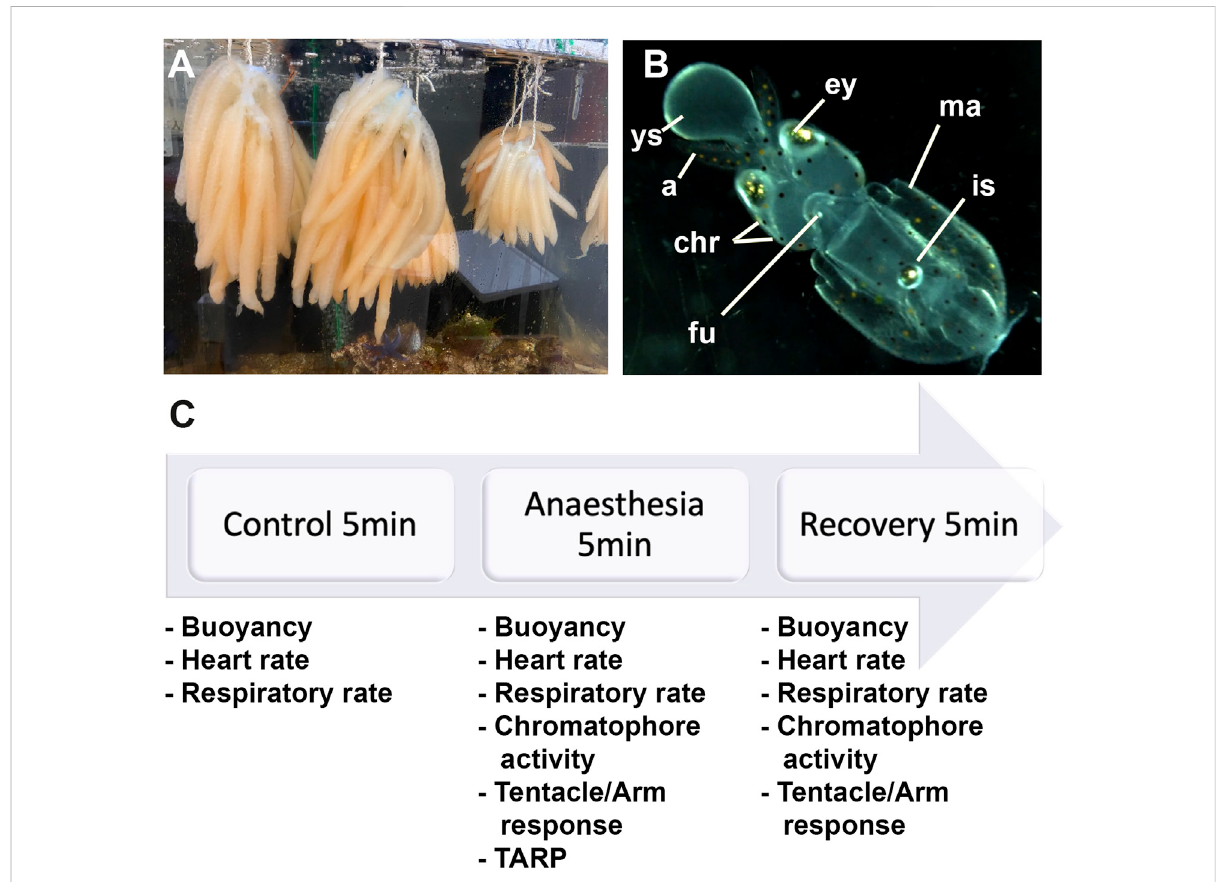
FIGURE 1 (A) Eggs of Loligo vulgaris suspended in bundles; each bundle contains between 15 and 30 arms. Each arm contains between 100 and 150 embryos. (B) Embryo stages 27 – 28; ys: external yolk sac, a: arms, ey: eyes, chr: chromatophores, fu: funnel, ma: mantel, is: ink sac. (C) Experiment